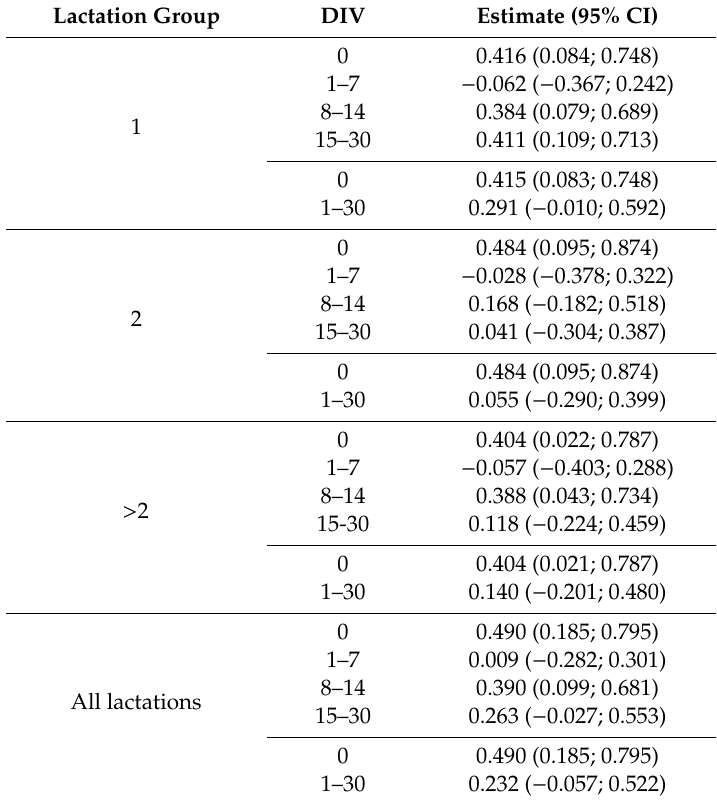
Table 1. Estimated lactation specific daily milk change per cow, in 73 dairy cattle farms in Israel at di ff erent time periods after vaccination. See text for details on